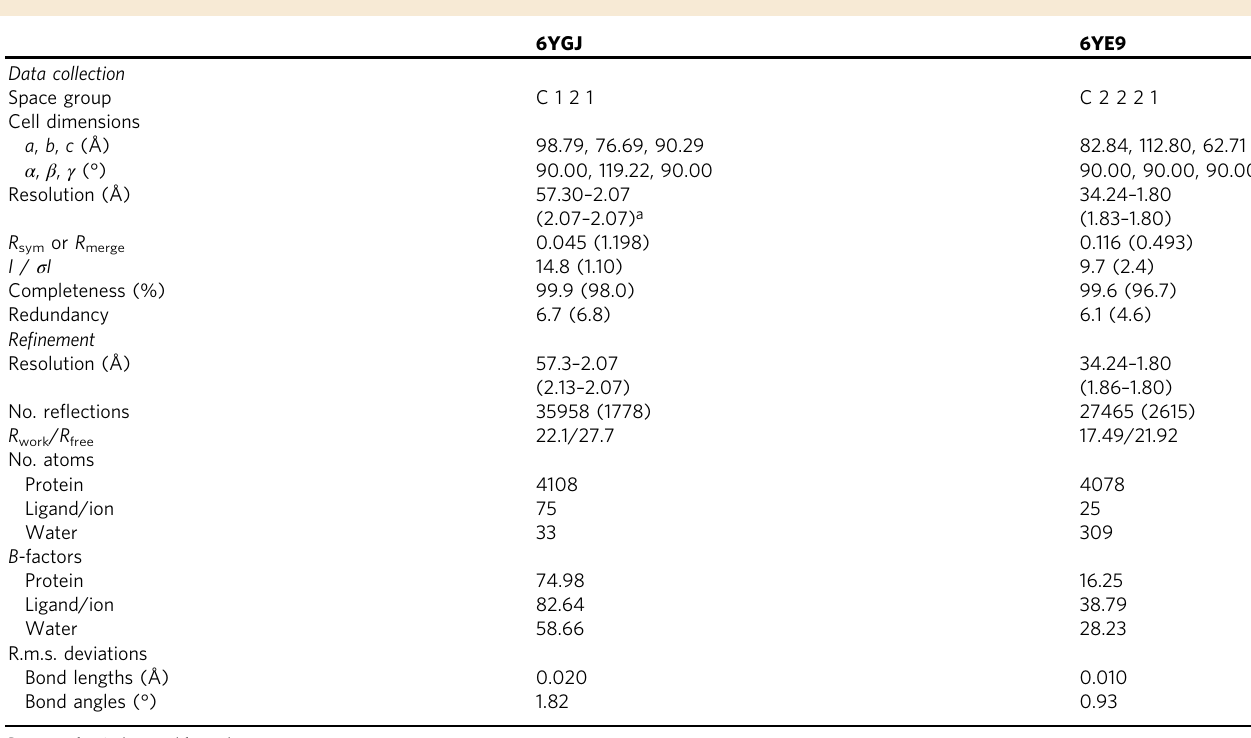
Datasets of a single crystal for each structure. a Values in parentheses are for highest-resolution